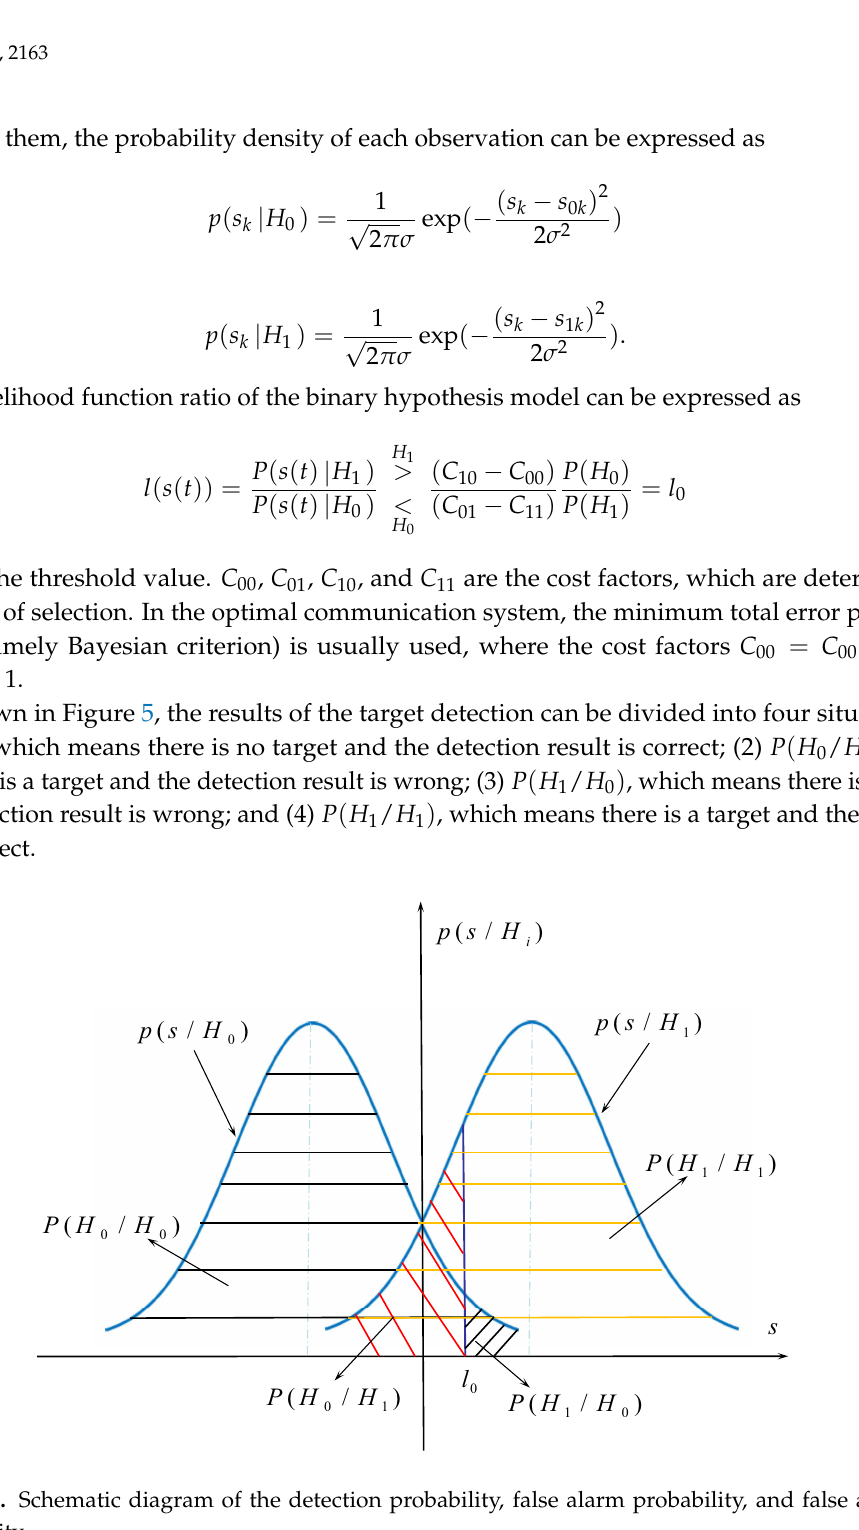
Figure 5. Schematic diagram of the detection probability, false alarm probability, and false alarm